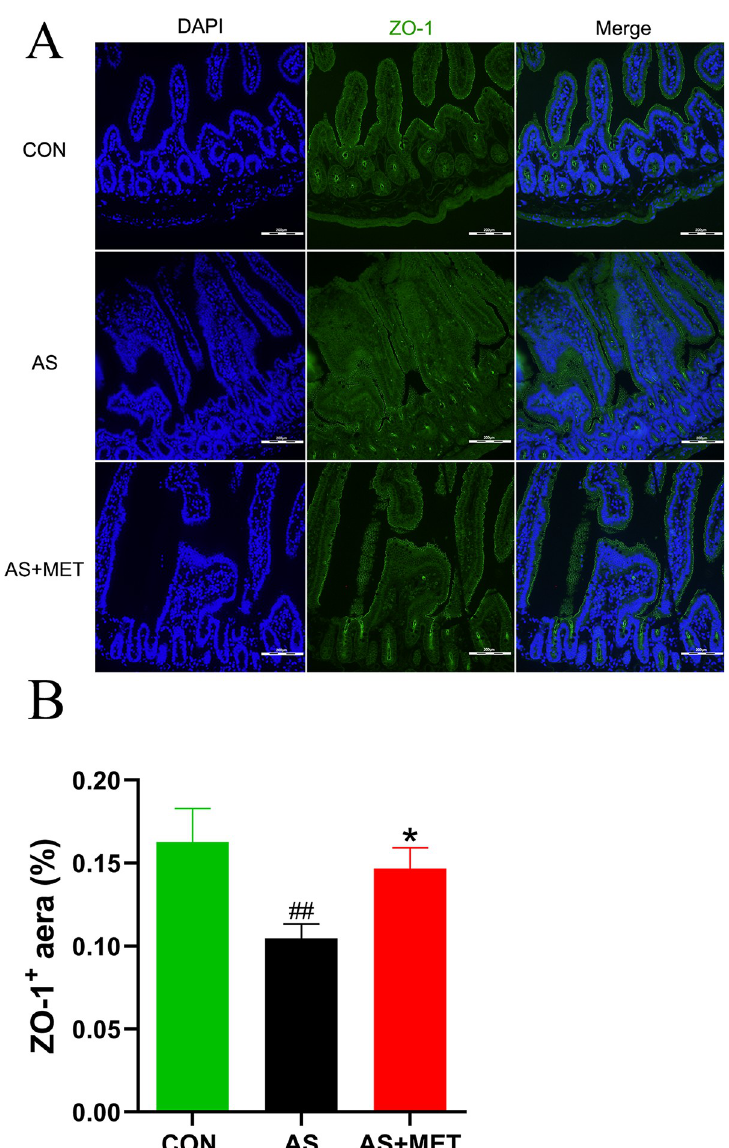
Fig 7. Determination of intestinal ZO-1 in diverse groups. (A) Quantitative analysis as ZO-1 area/total area Original magnification, × 100. The bar of 200 μ m was presented in the right corner of figure. (B) The expression level of ZO-1 in different groups. # (CON vs. AS): # p < 0.05, ## p < 0.01, ### p < 0.001. � (AS vs. AS+MET): � p < 0.05, �� p < 0.01, ��� p < 0.001. NS, no significant